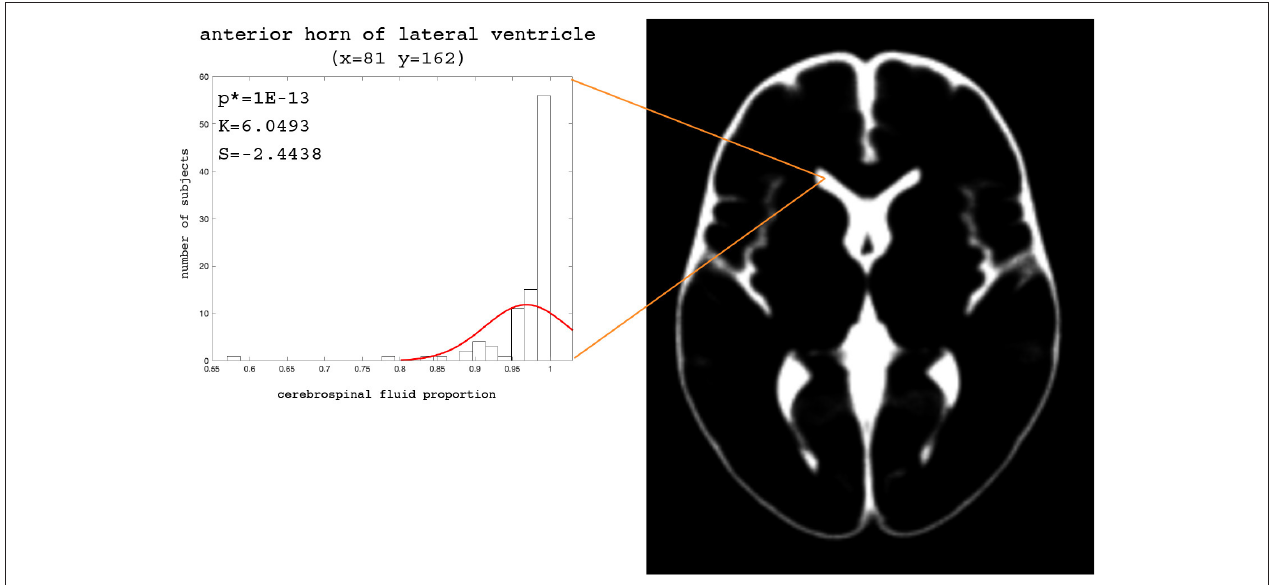
FIGURE 5 | Axial slice (z = 82) for the median CSF map. The histograms with the skewness (S), kurtosis (K), and Shapiro-Wilk test p -values (p*) for the anterior horn of the lateral ventricle.